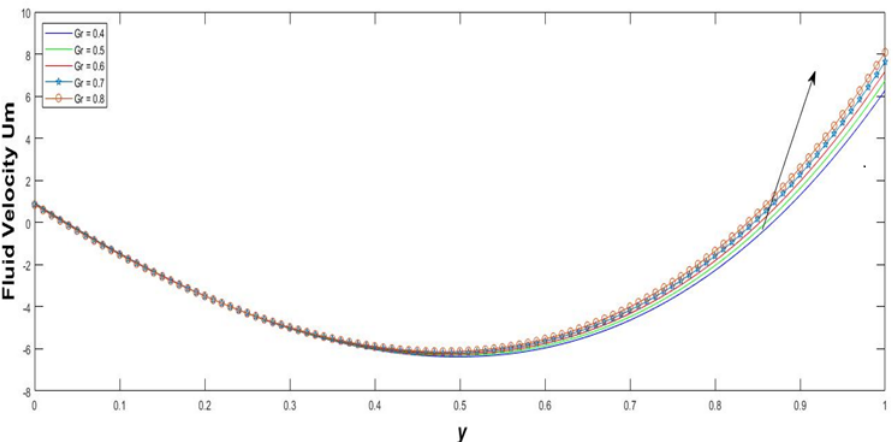
Figure 3. Velocity field for various Grashof numbers.